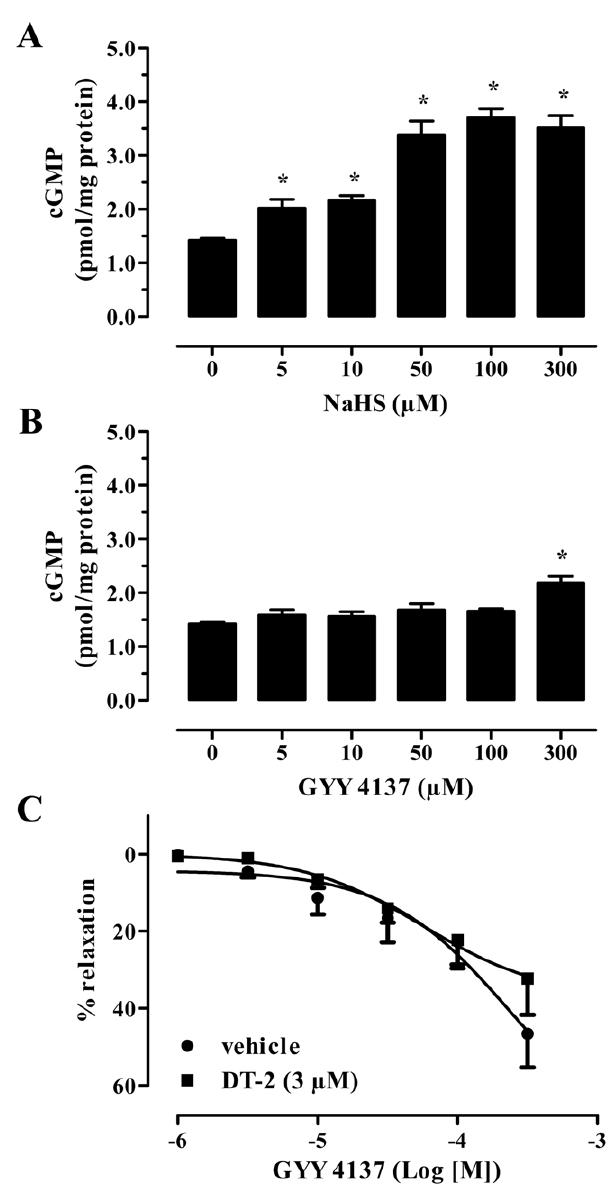
Figure 4. GYY4137-induced relaxation is independent of PKG. Aortic smooth muscle cells were exposed to the indicated concentra- tion of NaHS (A) or GYY4137 (B) and cGMP levels were determined after 5 min. *p , 0.05 control, n=4 for each group. (C) Incubation of isolated aortic rings with PKG selective inhibitor DT-2 (3 m M) did not affect GYY4137-induced vasodilatation; n=6 for each